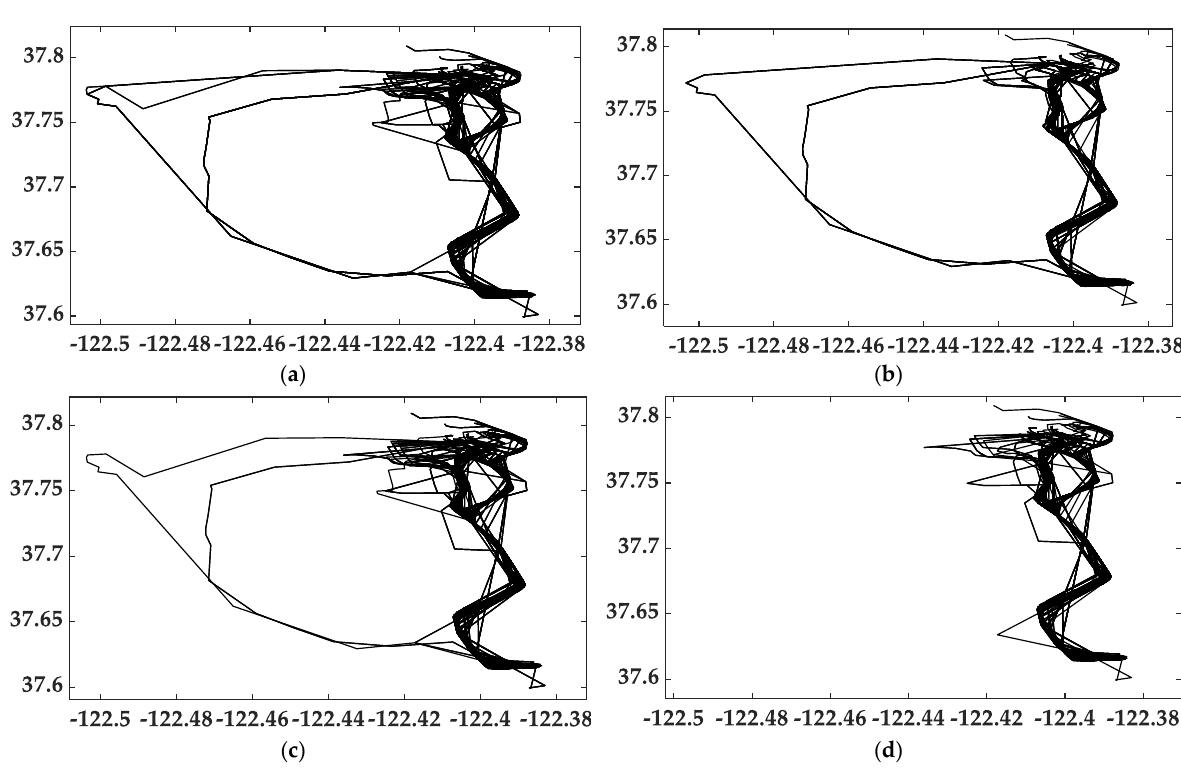
Figure 8. Visualization of the original trajectories: ( a ) T-1; ( b ) T-2; ( c ) T-3; ( d ) T-4.